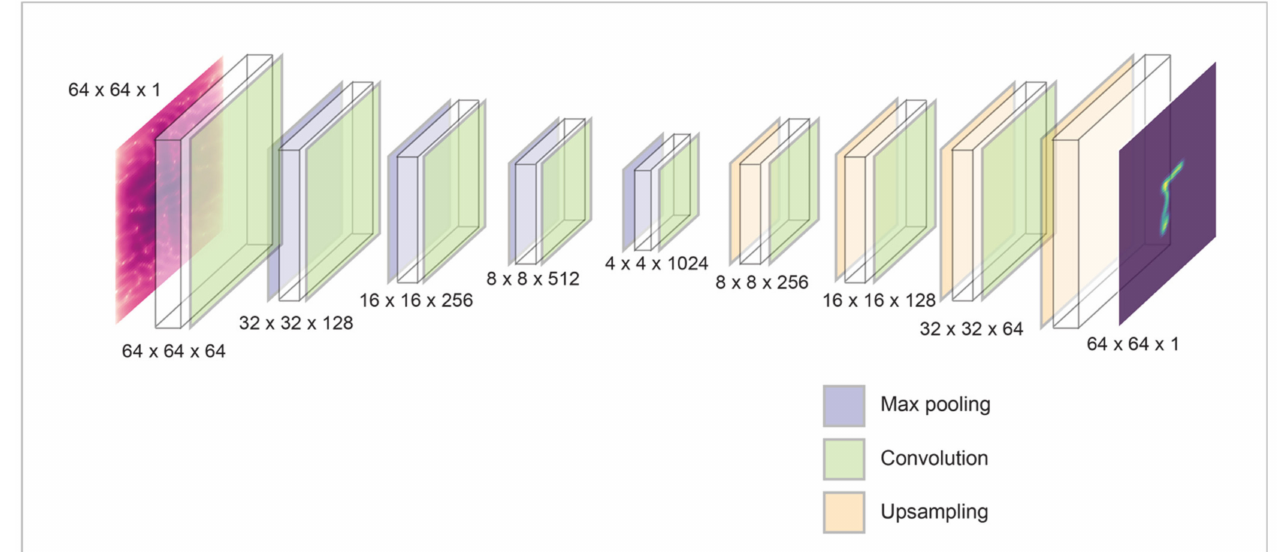
Figure 2. The architecture of 2D deep convolutional neural network for coherent X-ray imaging. The proposed neural network consists of two mirrored sub-networks. The diffraction pattern in reciprocal space and the object image in real space are input and output,